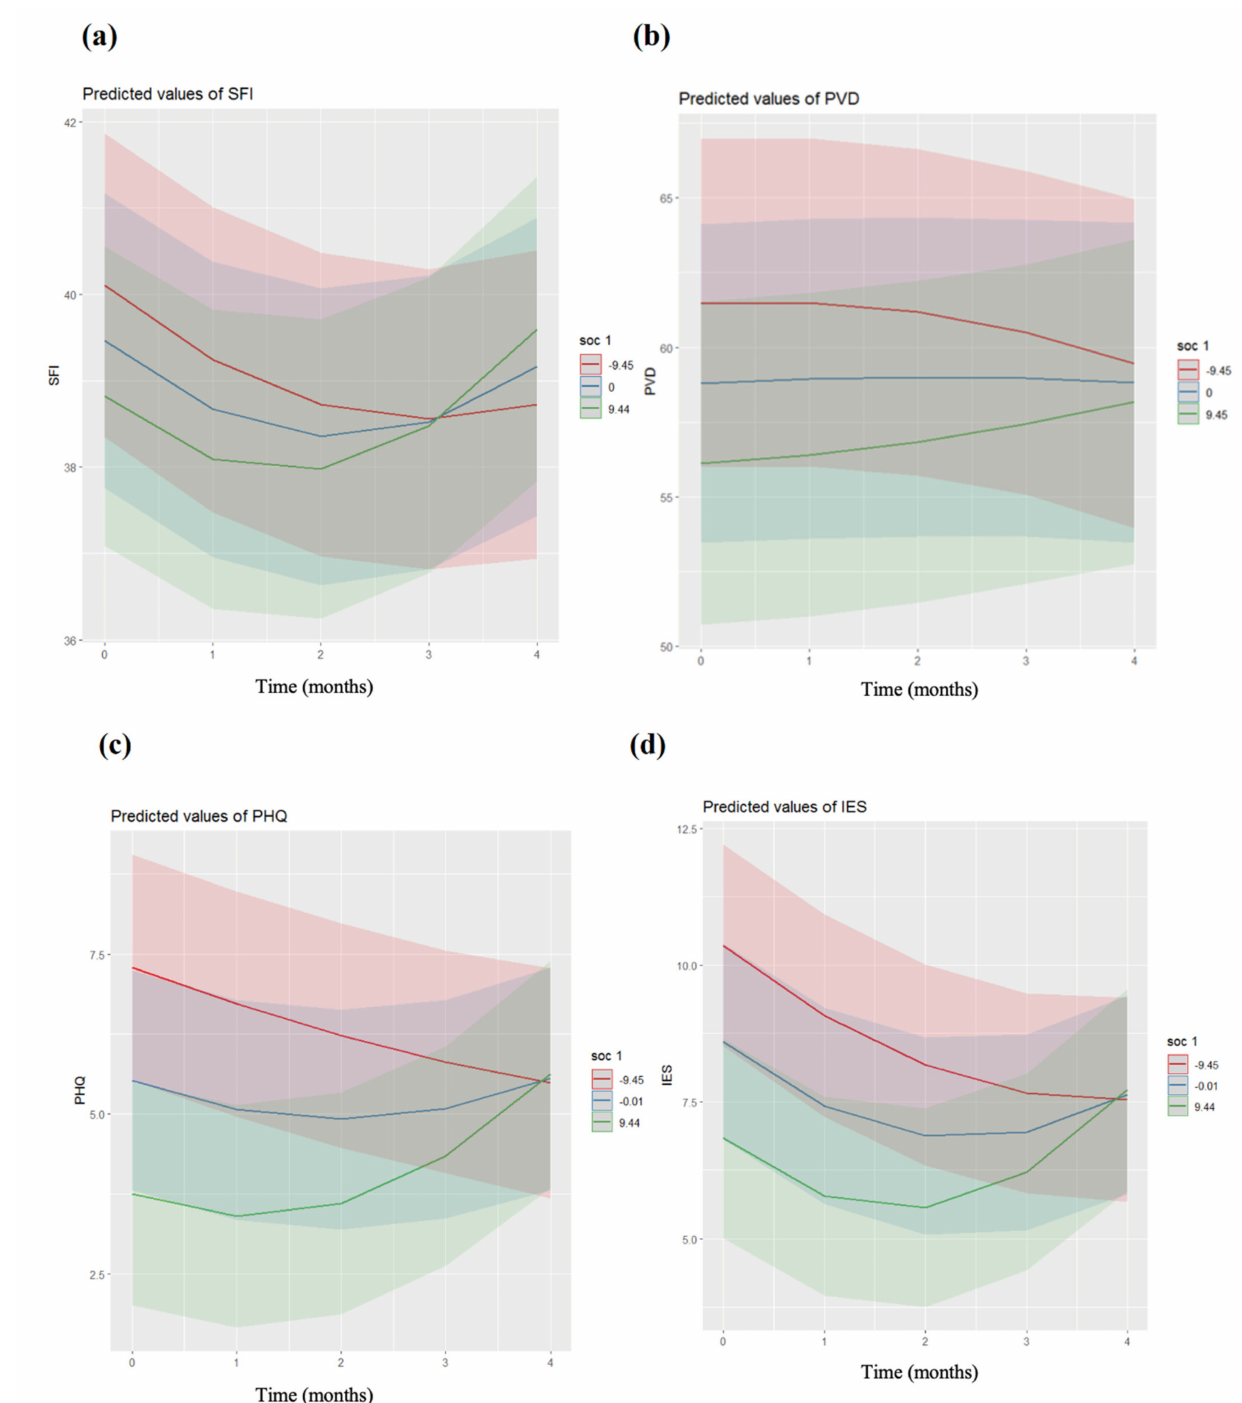
Figure 2. Trajectories of the mental health of the healthcare professionals across the measurement points for their Work-SOC levels (red, –1SD; blue, mean; green, +1SD). Slopes of COVID-19-related anxiety ( a ), perceived vulnerability ( b ), depressiveness ( c ), and psychological trauma symptoma- tology ( d ), all by Work-SOC levels. The shaded areas correspond to the confidence intervals of each trajectory. Number − 9.45 = − 1SD (lower Work-SoC), +9.45 = +1SD (higher Work-SoC). Time points: T0, April 2020; T1, July 2020; T2, October 2020; T3, January 2021; T4, April 2021. m-SFI, modified Swine Influenza Anxiety Index; PVD, Perceived Vulnerability to Disease Scale; PHQ, Patient Health Questionnaire; IES, Impact of Event Scale; Work-SoC, Work-related Sense of Coherence Scale. Colour-shaded areas represent the SD. The figures were directly plotted by R